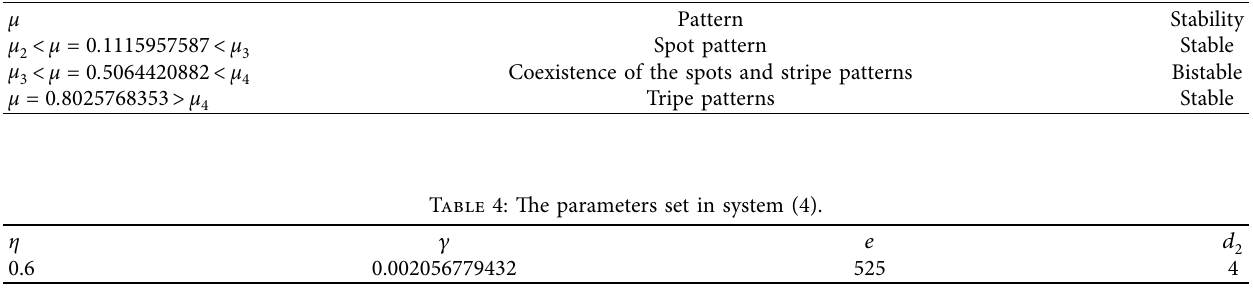
Table 3: The pattern selection of model (4).